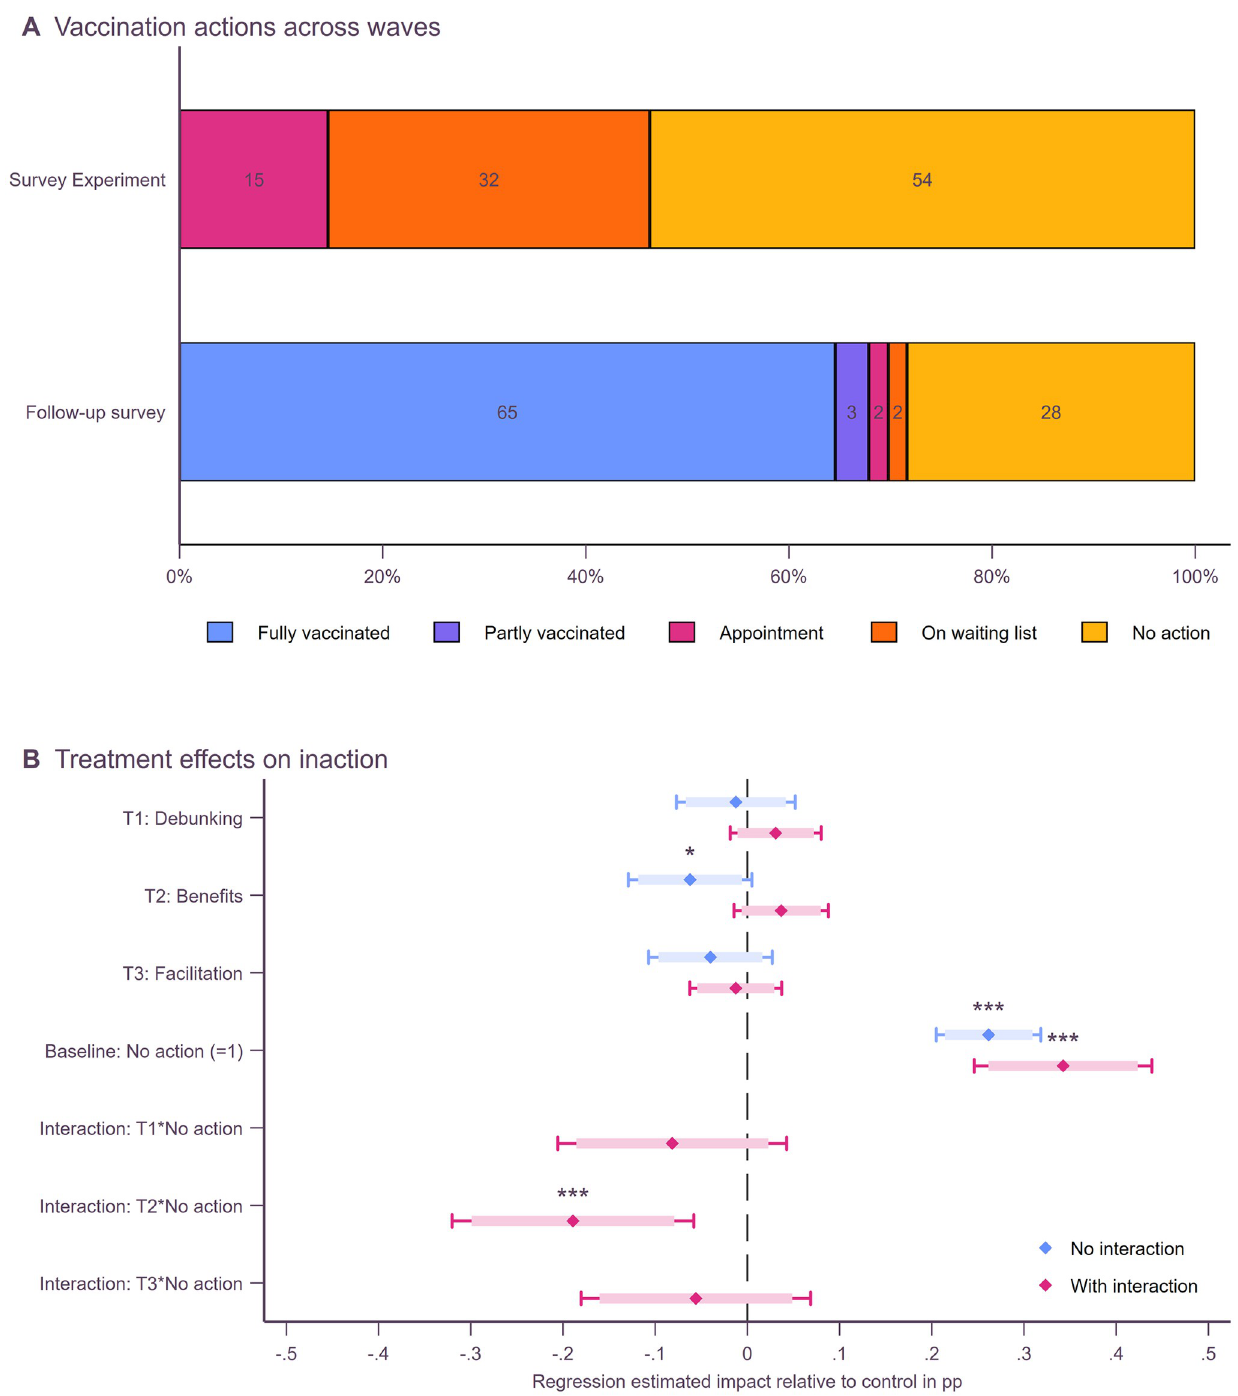
Fig 4. Self-reported actions of the balanced panel. Panel A shows the actions taken by participants across both waves. Panel B shows regression estimates with no action in the second wave as the dependent variable from linear probability models controlling for gender, age, education, adjusted household income, marital status, denied other vaccines, COVID-19 risk perception, emotional response, net anticipated regret, and dogmatism. Heteroscedasticity robust standard errors were used to compute 95% (thin bars) and 90% (thick bars) confidence intervals. Full regression outputs and robustness checks using non-linear Probit regression models are reported in S9